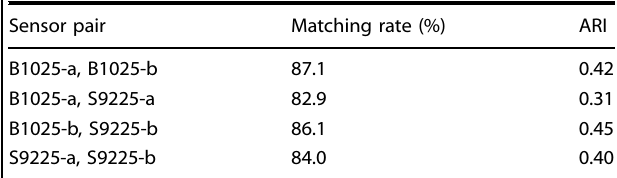
Table 2. Validity metrics for Experiment